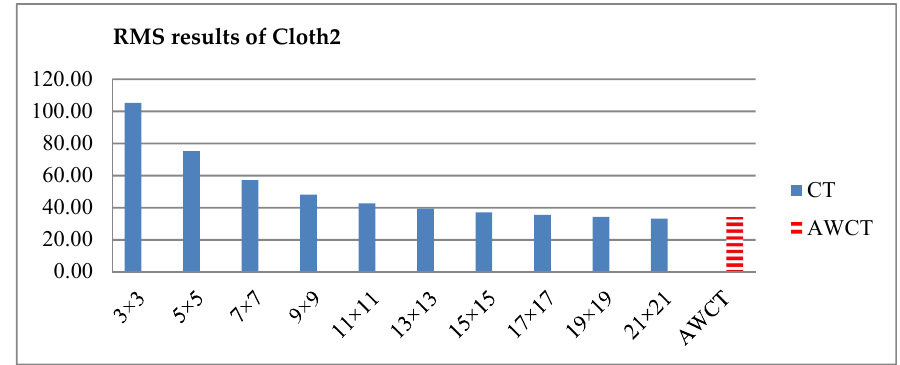
Figure 17. RMS comparison results of Reindeer between AWCT and CT. Sensors 2020 , 20 , x FOR PEER REVIEW